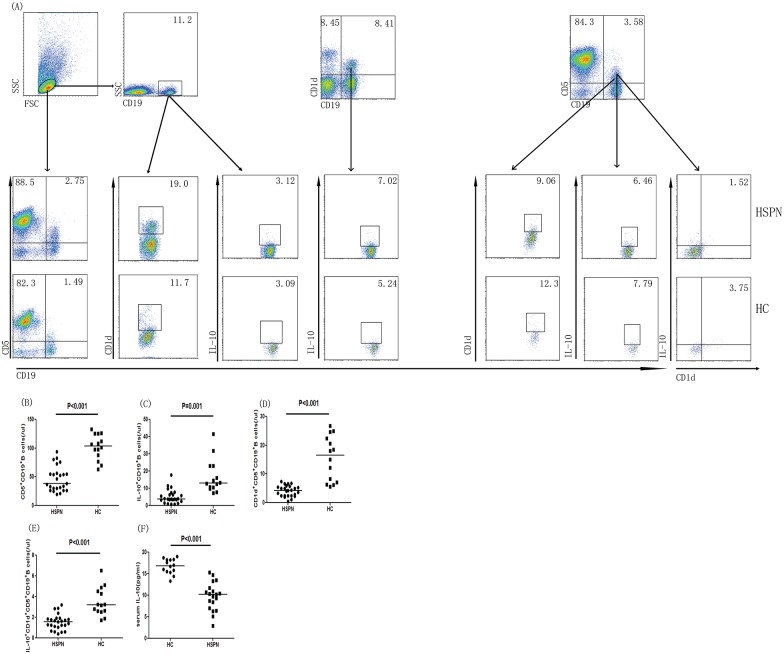
Flow cytometric analysis of Bregs isolated from PBMCs of HSPN patients and healthy controls.The cells were stained with anti-CD19, anti-CD5, anti-CD1d, and intracellular anti-IL-10 or isotype-matched IgG. The cells were characterized by flow cytometric analysis; living lymphocytes were gated initially, followed by gating on CD19+ B cells. Subsequently, we analyzed the numbers of CD5+CD19+, CD1d+CD5+CD19+, and IL-10+CD1d+CD5+CD19+ B cells among CD19+ B cells, and at least 30,000 events per sample were analyzed. (A) Flow cytometric analysis. (B) The numbers of CD5+CD19+ B cells. (C) The numbers of IL-10+CD19+ B cells. (D) The numbers of CD1d+CD5+CD19+ B cells. (E) The numbers of IL-10+CD1d+CD5+CD19+ B cells. (F) Serum concentrations of IL-10. Data are expressed as the means or concentrations for individual subjects that participated in two separate experiments. The horizontal lines represent the median values of each group. Data were analyzed by the Mann-Whitney U-test.